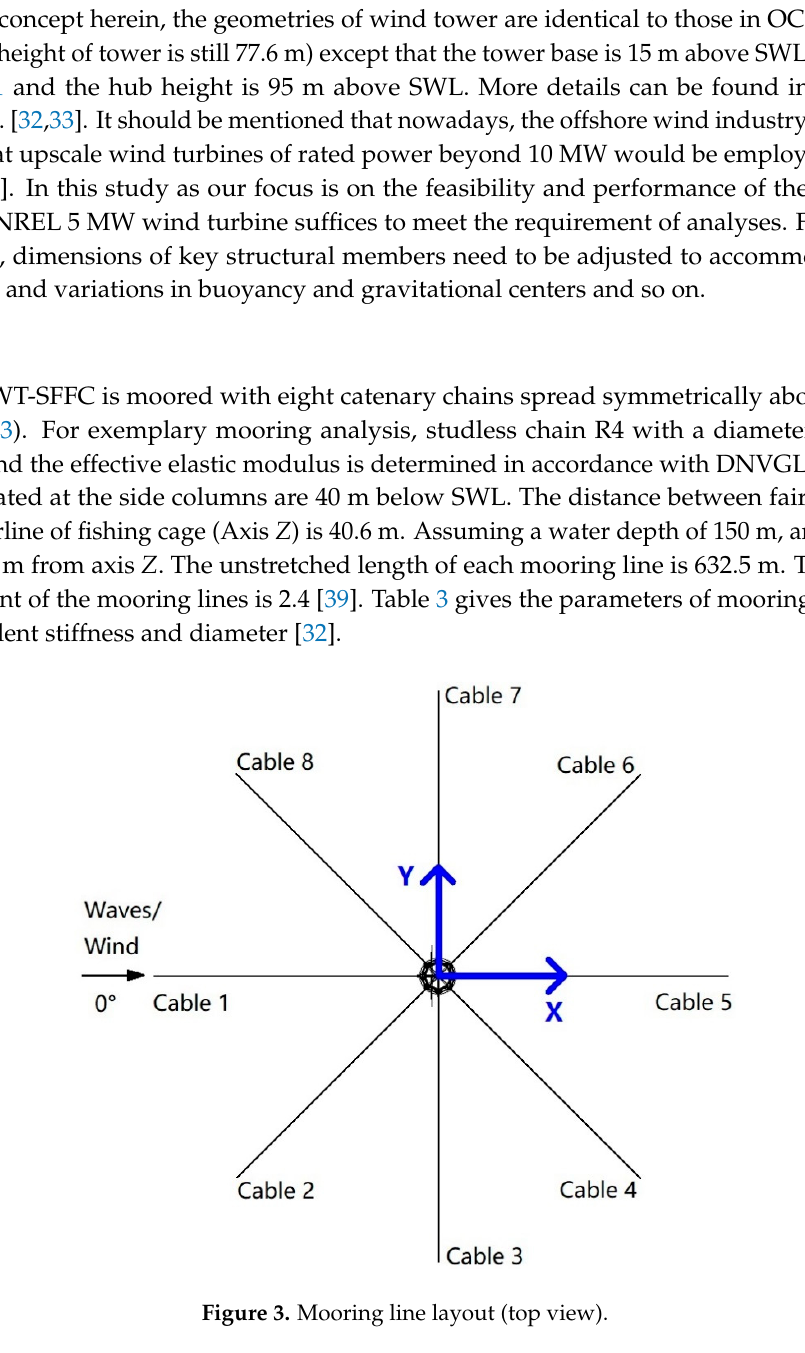
5 of 19 Table 2. Mass breakdown of fishing cage. Key Components